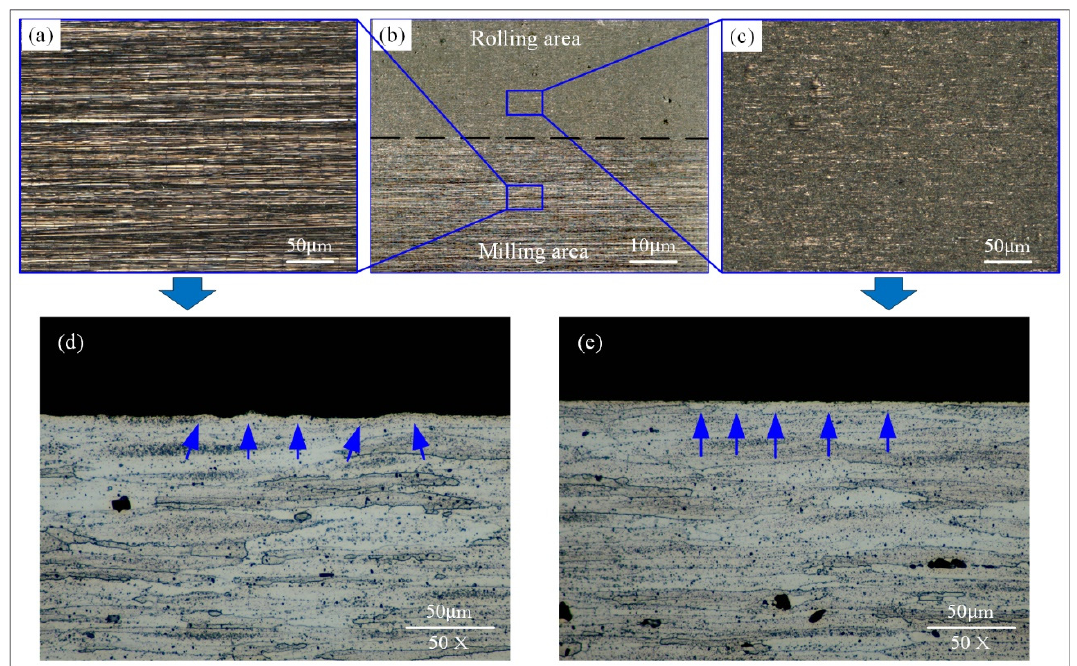
Figure 9. Changes in surface morphology and microstructure of T1 sample after rolling correction treatment: ( a – c ) surface morphology of rolling area and milling area; ( d ) microstructure of milling area in depth direction; and ( e ) microstructure of rolling area in depth direction.